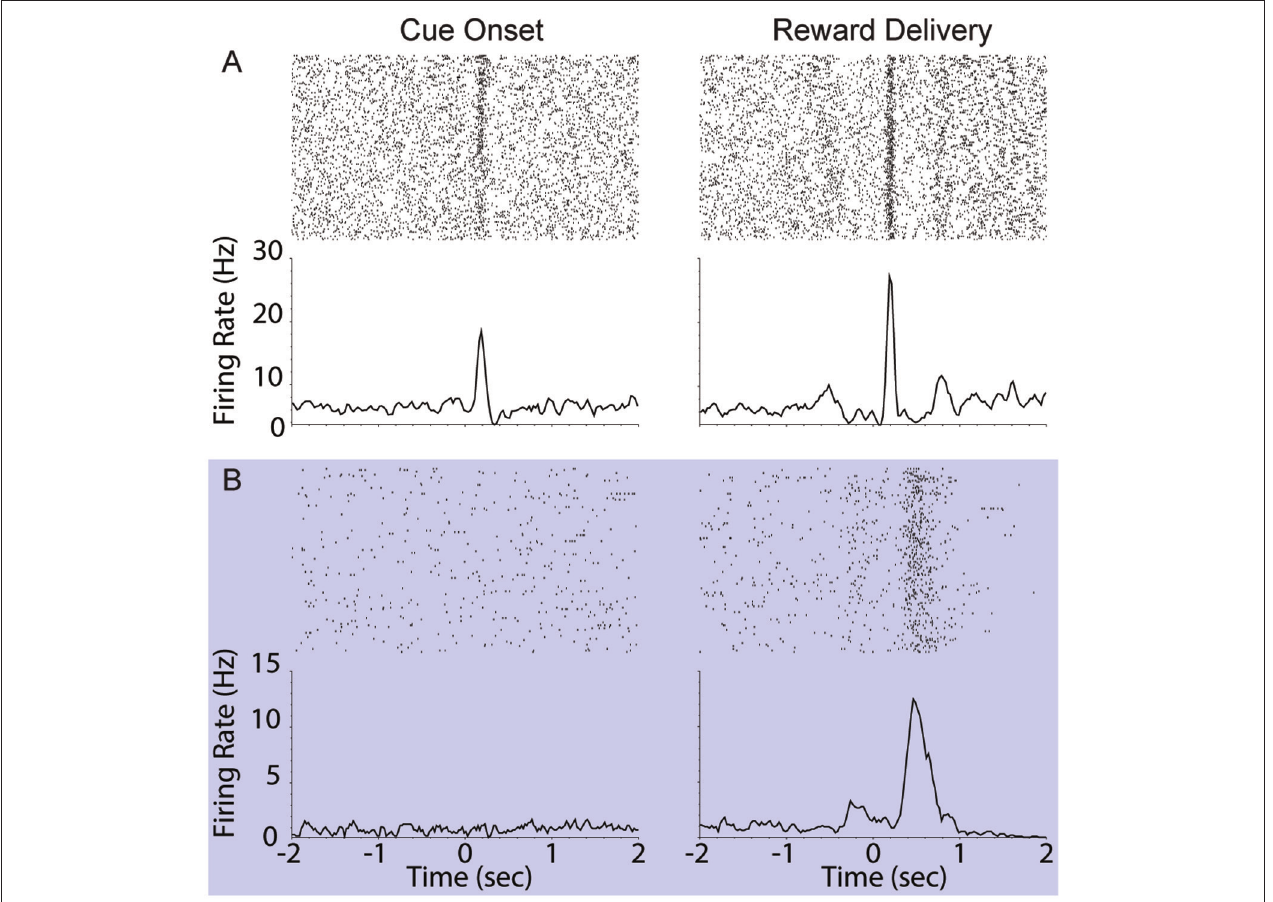
FIGURE 9 | Example VTA responses to cue onset and reward delivery in first session (FR01) and final RR10 session. (A) Top left panel depicts representative example raster of cue evoked response (cue onset at time = 0; trials arranged in chronological order starting at top). Each dash represents one spike. Smoothed mean response is depicted below raster. The same neuron’s response to reward delivery is depicted in the upper right panel. Note the phasic response to both cue onset and reward delivery in the FR01 session (top row). (B) Representative example neuronal responses recorded in final RR10 session [data recorded from same animal in (A,B) ]. Data depicted similarly to (A) with different Y axis on bottom panels. Note that this neuron responds to reward delivery, but not cue